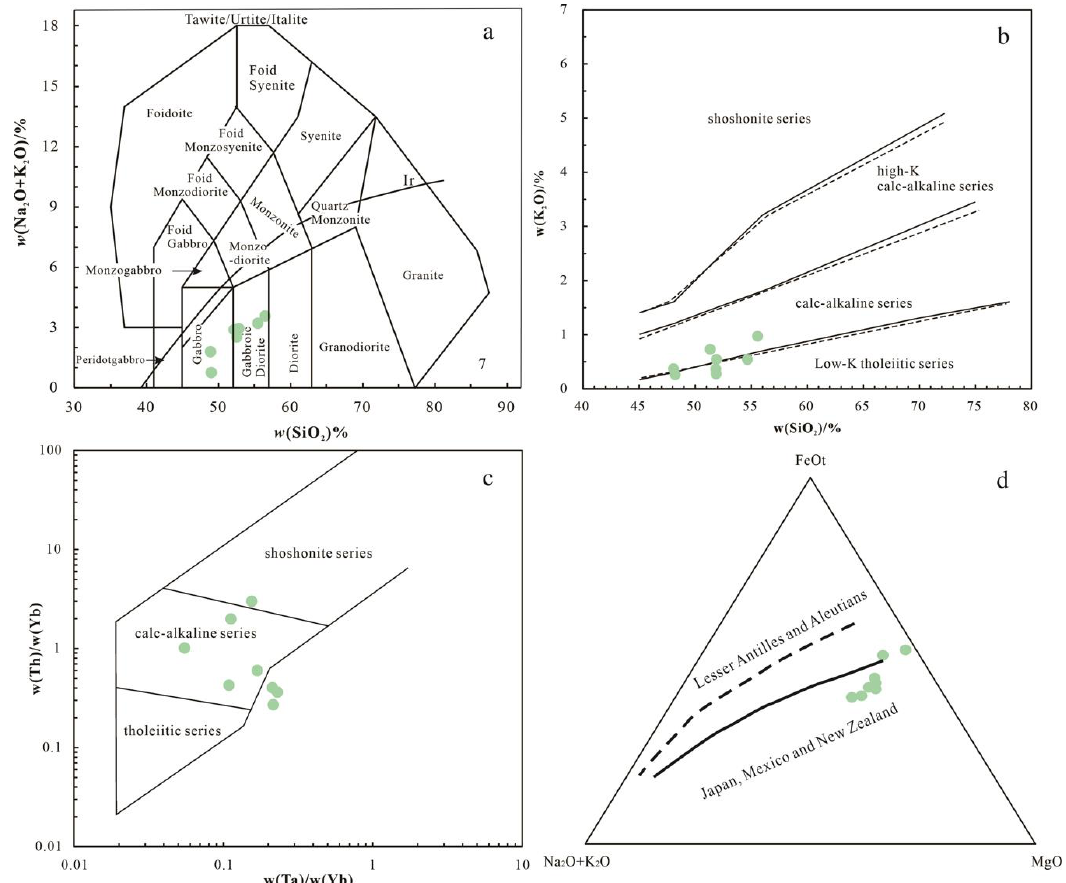
Figure 4. Total alkali vs. silica (TAS) diagrams ( a ), modified from Middlemost [50]; K 2 O vs. SiO 2 ( b ), modified from Winchester and Floyd [51]; Th/Yb vs. Ta/Yb ( c ), modified from Pearce [52]; and Total alkali—Total FeOt- MgO (AFM) classification diagrams ( d ) after Coleman [53] for Yuejingshan gabbro samples.